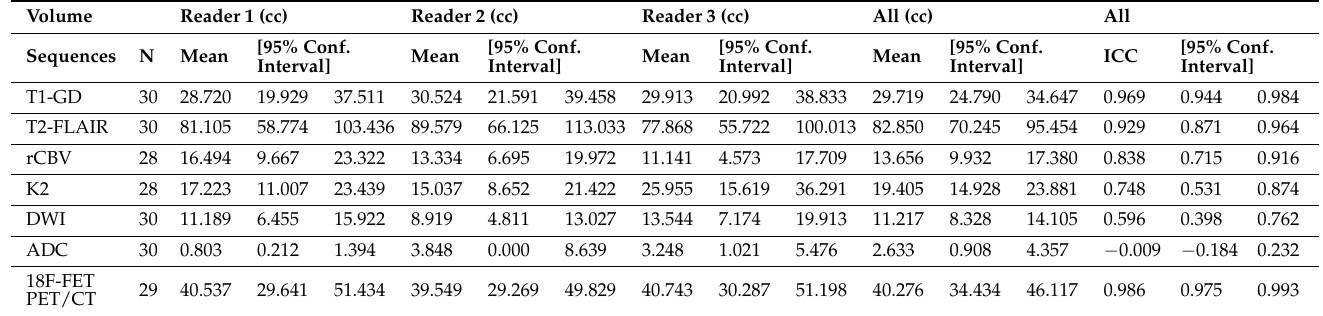
Table 5. The average volumes delineated for each sequence and the ICC between each